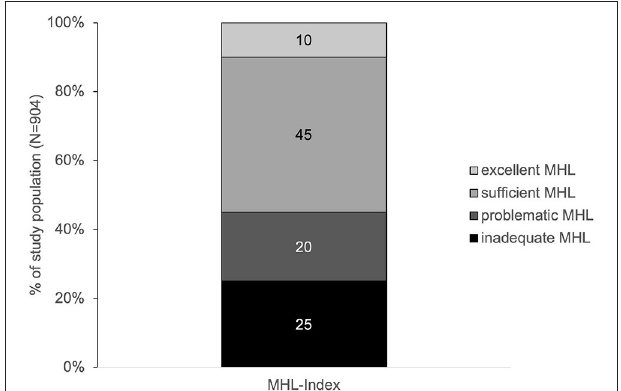
FIGURE 1 | MHL levels in percentage of the study